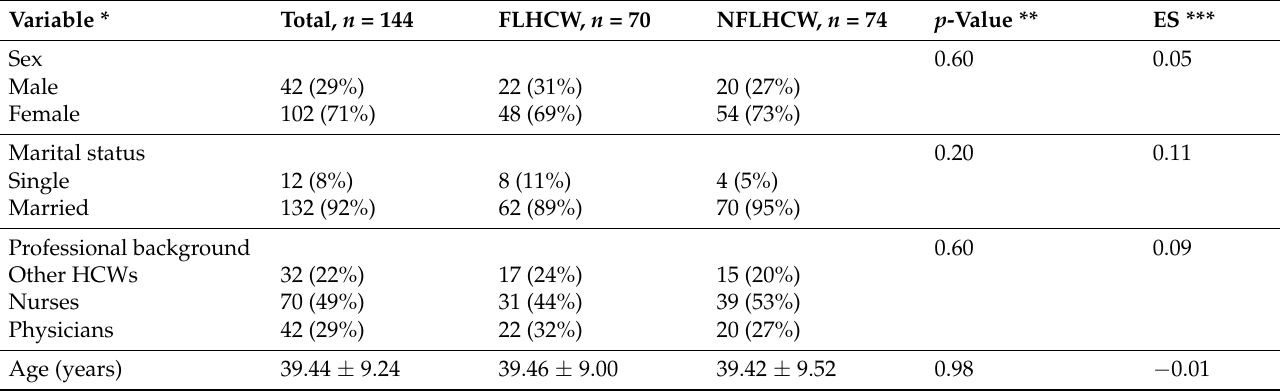
Table 1. Demographics of the study participants.